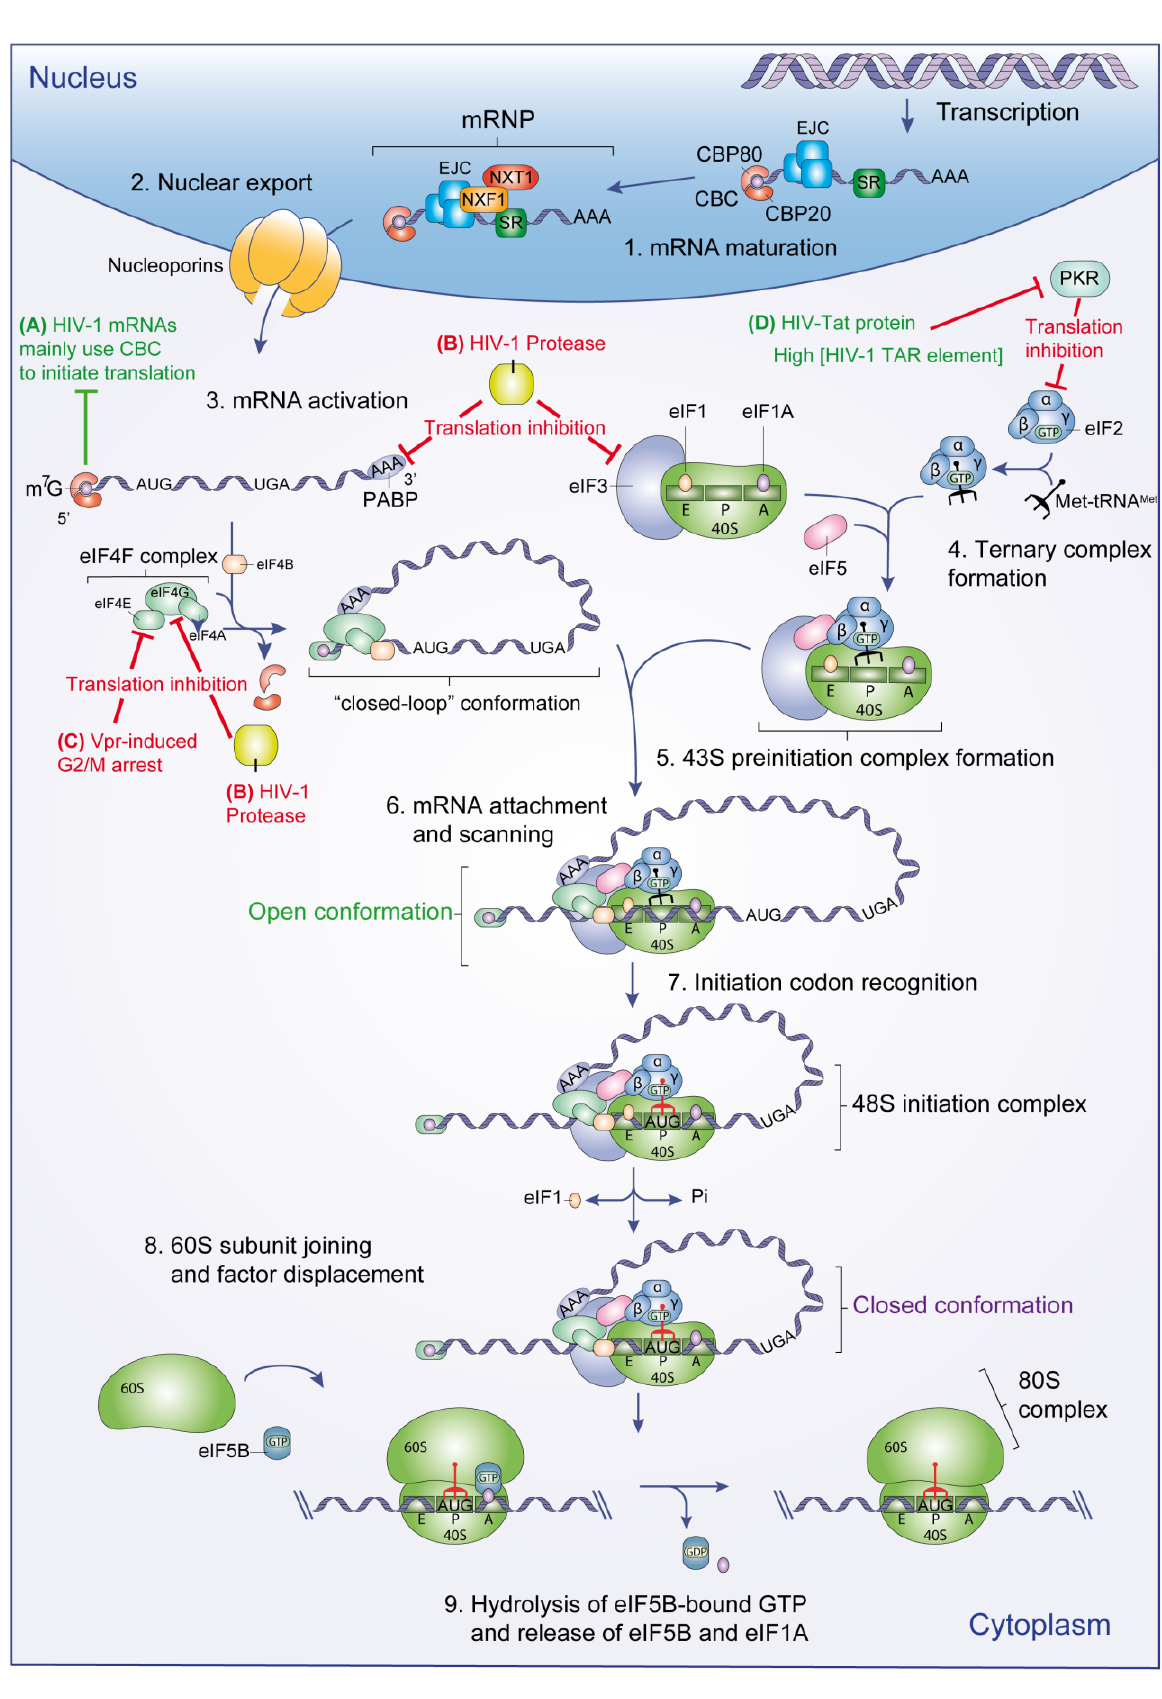
Figure 1. Eukaryotic translation initiation. mRNA maturation and nuclear export precede translation initiation (steps 1 and 2). Once in the cytoplasm, mRNA is activated (step 3)